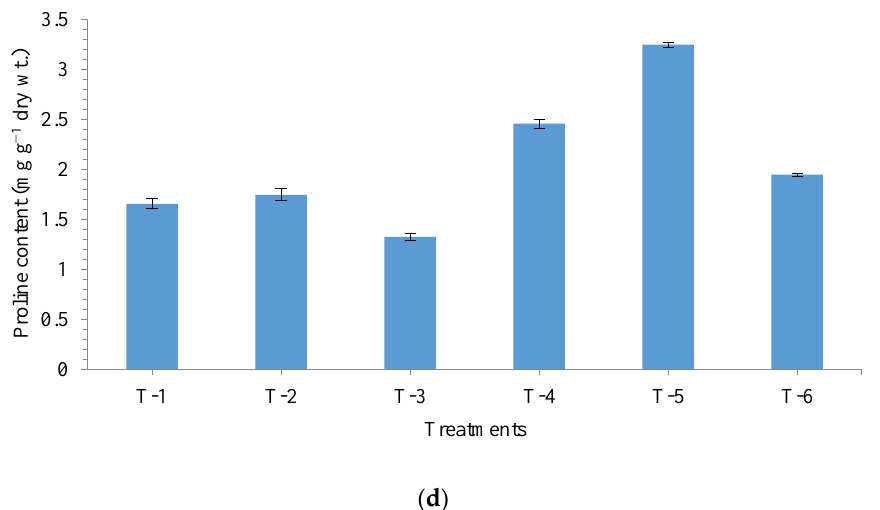
Figure 5. Effects of seed bio-primingon ( a ) total chlorophyll content, ( b ) total carotenoids content, ( c ) total soluble sugar, and ( d ) proline content in maize at 30 days after sowing. Treatments were: T 1 -Saline sodic soil (Negative control), T 2 -Non-saline sodic soil + Salt (NaCl 150 mM), T 3 -Non-saline sodic soil (Positive control), T 4 -Saline sodic soil + Pseudomonas geniculata MF-84, T 5 -Non-saline sodic soil + Salt (NaCl 150 mM) + Pseudomonas geniculata MF-84 and T 6 -Non-saline sodic soil + Pseudomonas geniculata MF-84. Data are mean ± SEM ( n = 5).